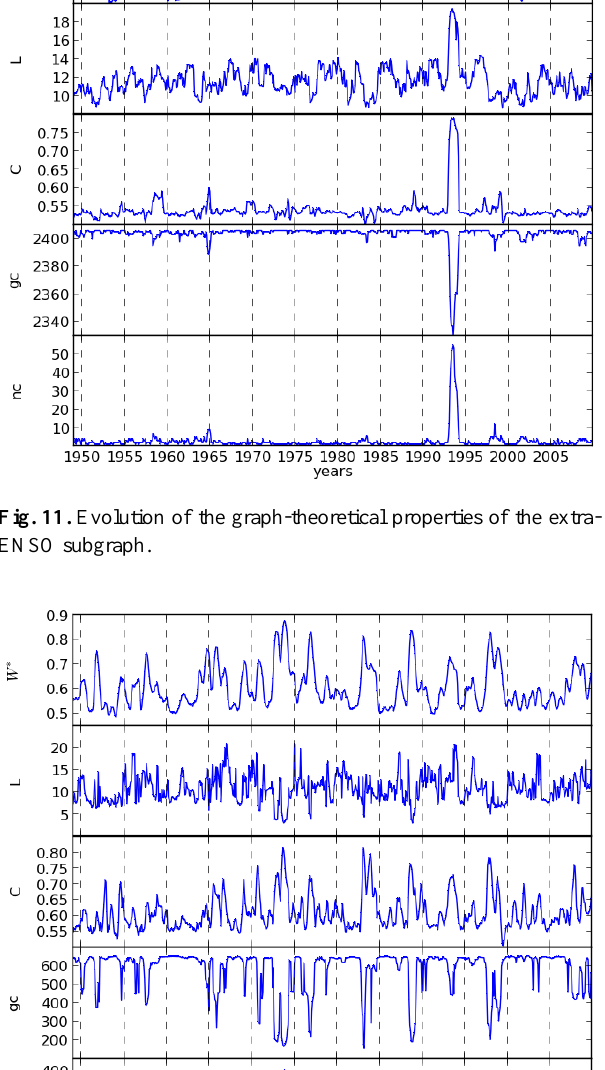
Fig. 12. Evolution of the graph-theoretical properties of the tropics subgraph.